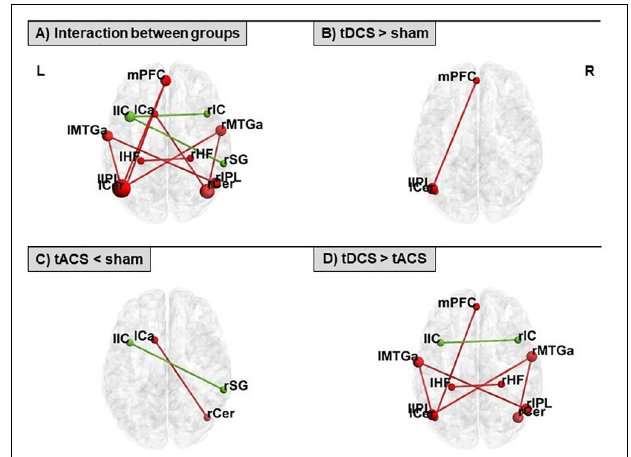
FIGURE 3 | Seed-to-seed statistically significant results within the DMN (in red) and the ECN (in green) for: (A) interaction between groups, (B) tDCS > sham, (C) tACS < sham, and (D) tDCS > tACS. tDCS, transcranial direct current stimulation; tACS, transcranial alternating current stimulation. For ROI abbreviations see Table 1